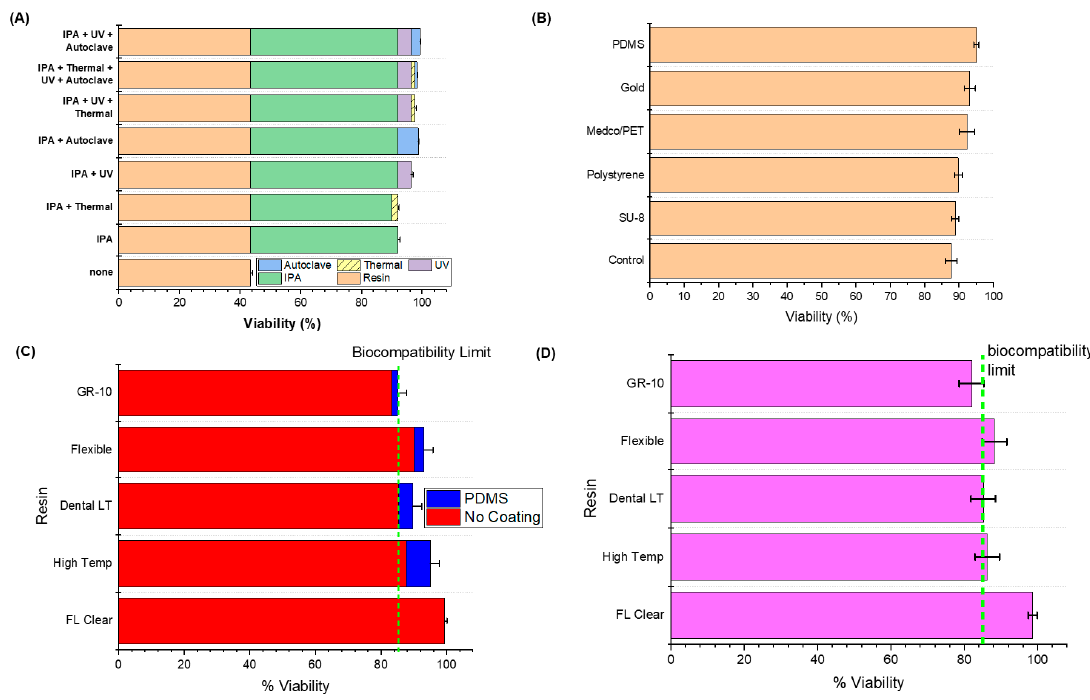
Figure 3. ( A ) Biocompatibility results of incremental improvements in biocompatibility during